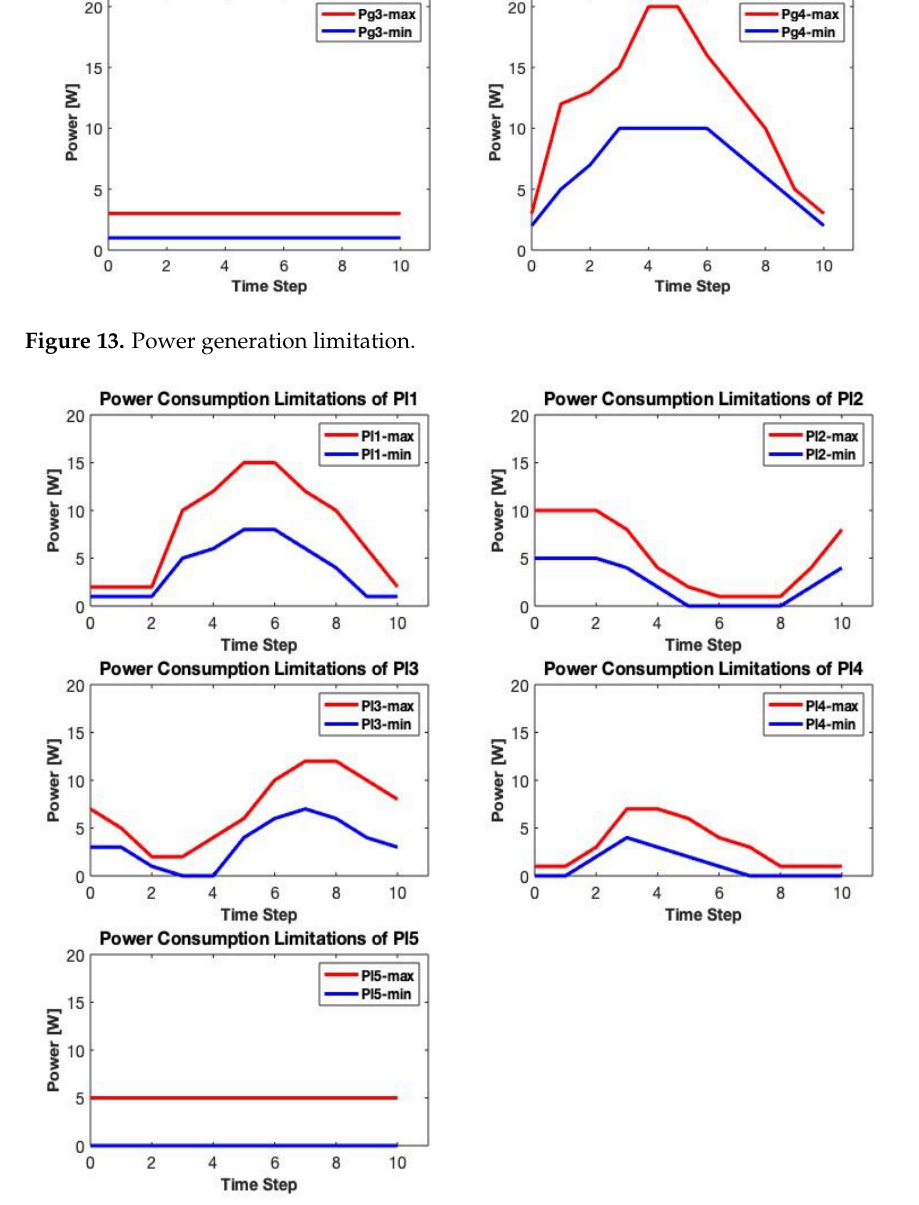
Figure 14. Power consumption